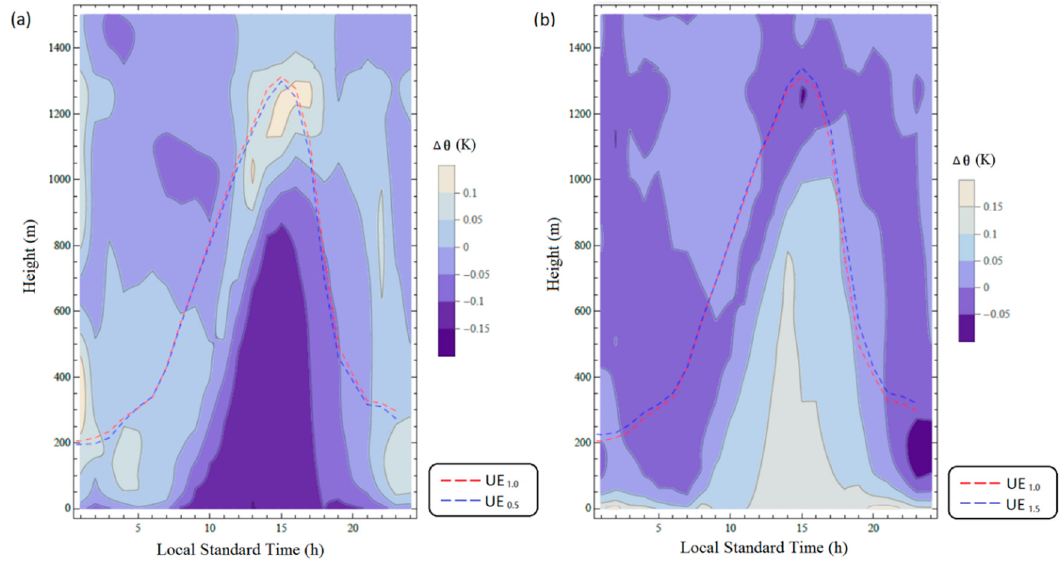
Figure 7. Mean (2–5 July 2013 LST) vertical potential temperature difference ( Δ θ ) between scenarios: ( a ) UE 0.5 and UE 1.0 , and ( b ) UE 1.5 and UE 1.0 in Hangzhou. Height of urban boundary layer, as diagnosed by Mellor and Yamada [44] and Janji ć [45] planetary boundary layer (PBL) scheme.